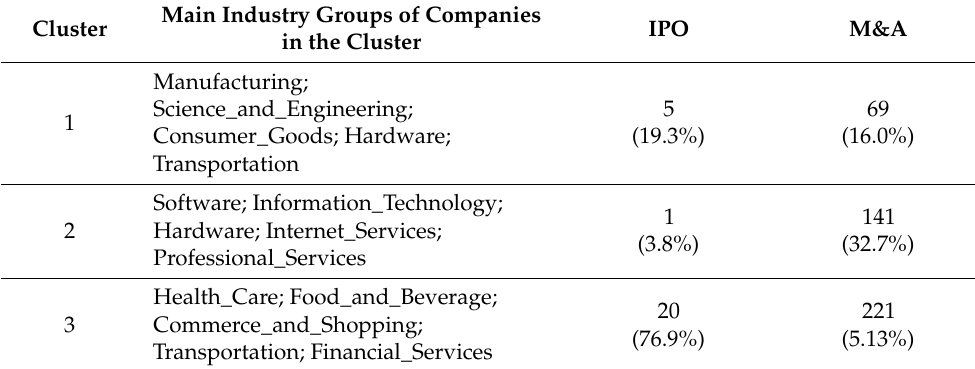
Table 10. Analysis of Exited Companies by Clusters.